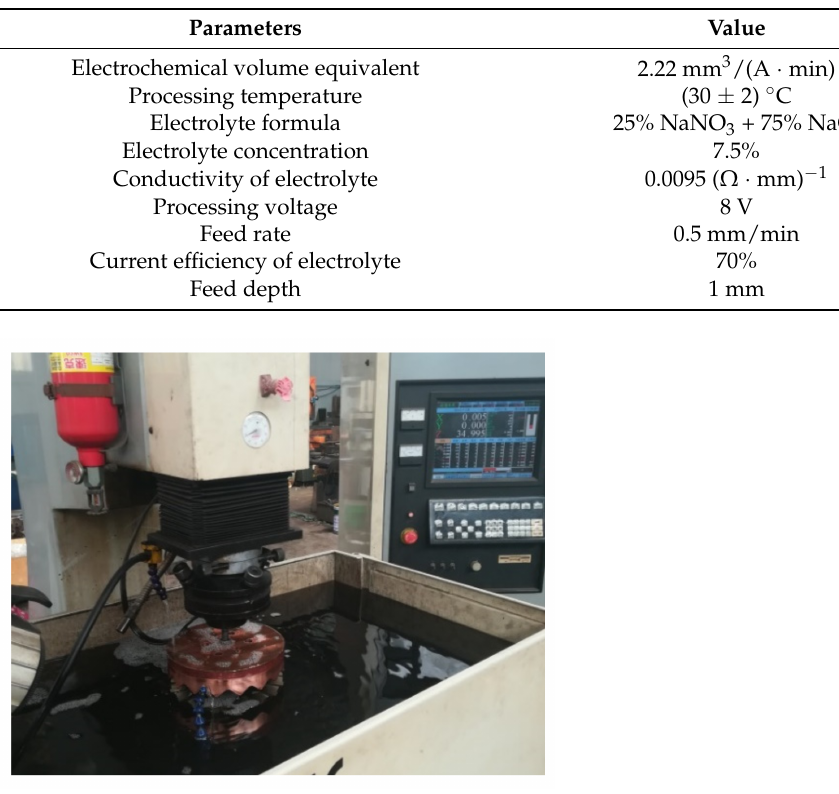
Figure 10. Electrochemical machining process of face gear.